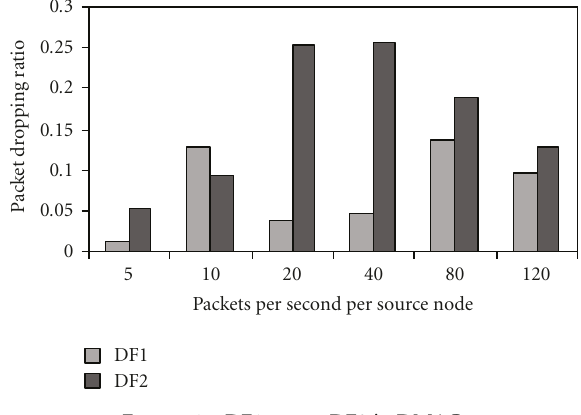
Figure 17: DF1 versus DF2 in